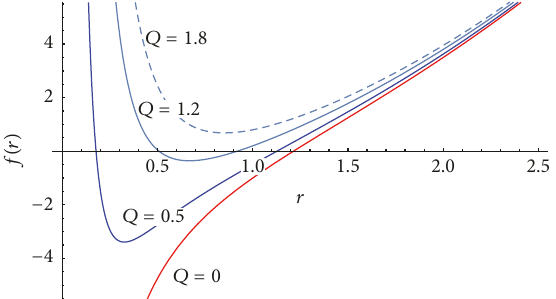
Figure 2: The figure shows 𝑓(𝑟) versus 𝑟 for 𝛾 = −1 for varying 𝑄 . Here 𝜆 = 2.4 , Λ = −3 , and 𝑀 = 1.5 .